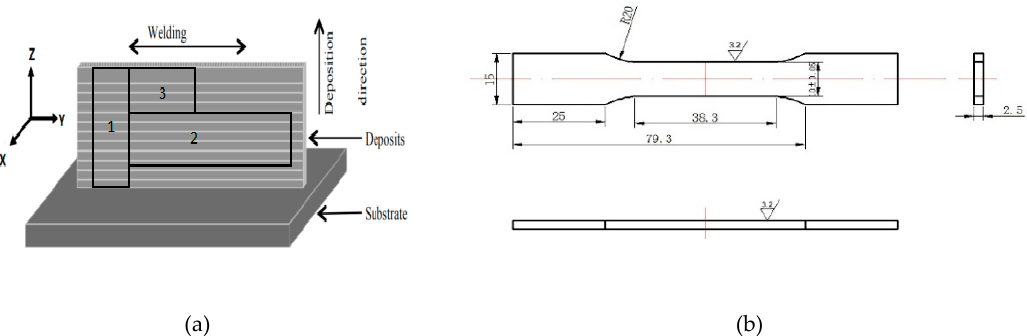
Figure 2. ( a ) definition of coordinates for wall and ( b ) dimensions of the specimen (the units for the specimen’s dimensions are mm).